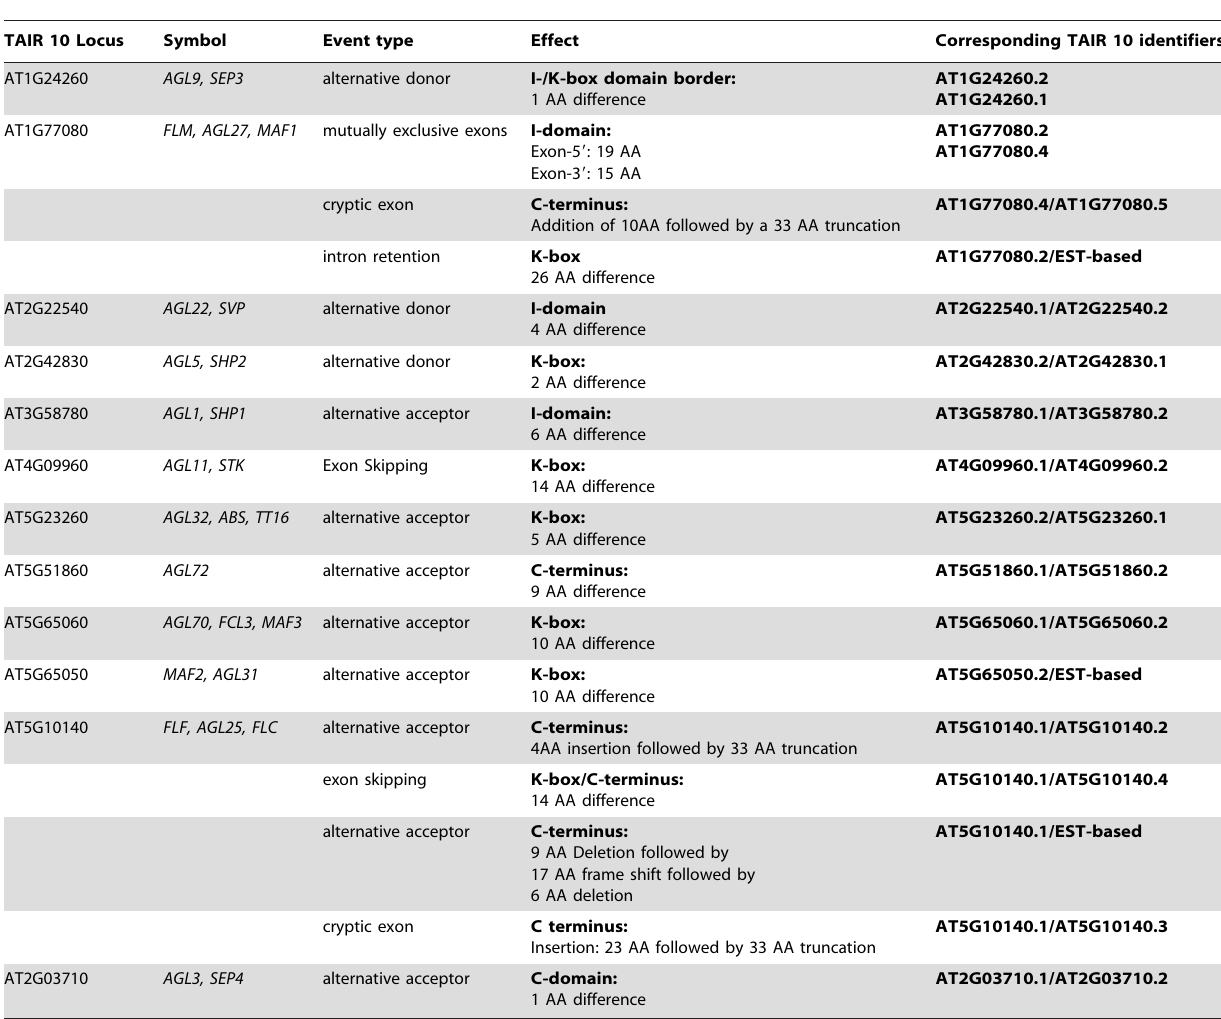
Table 1. Alternative spliced loci producing multiple protein isoforms.